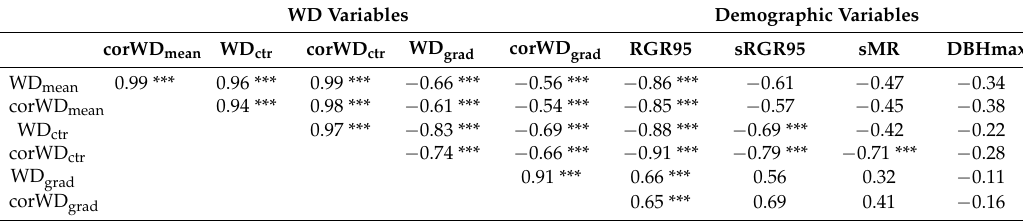
Table 3. PearsoncorrelationsamongWDvariablesandbetweenWDvariablesanddemographicparameters. WD